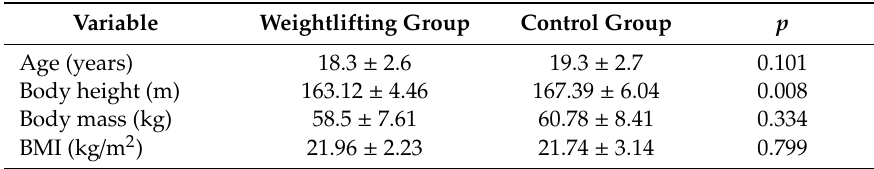
Table 1. Anthropometric characteristics of the